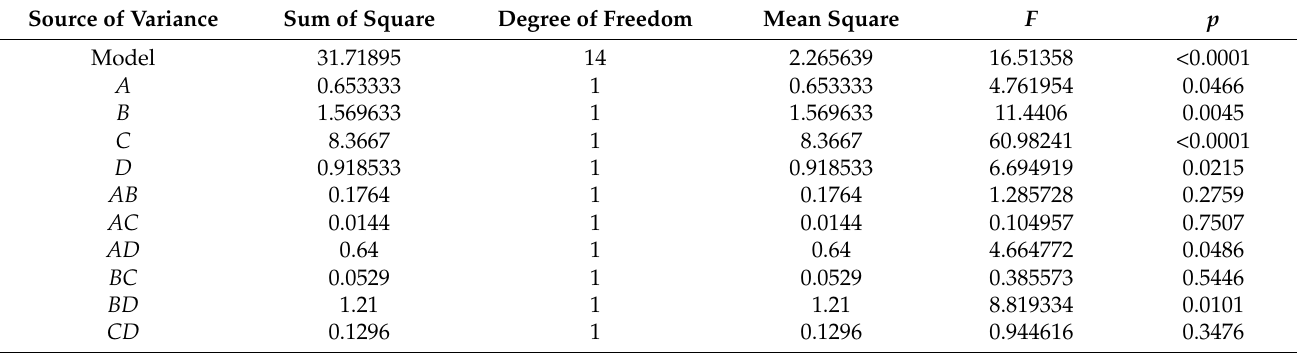
Table 5. Analysis of variance of regression